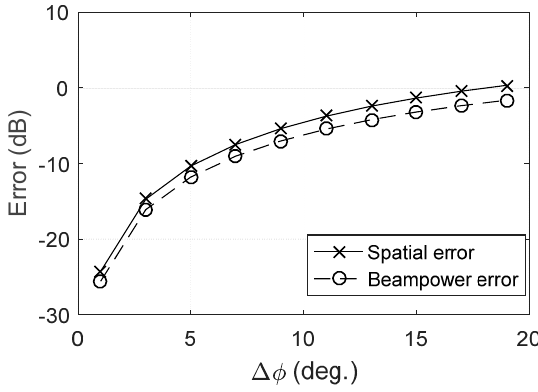
Figure 6. Spatial error and beam-power error with respect to Δ φ .